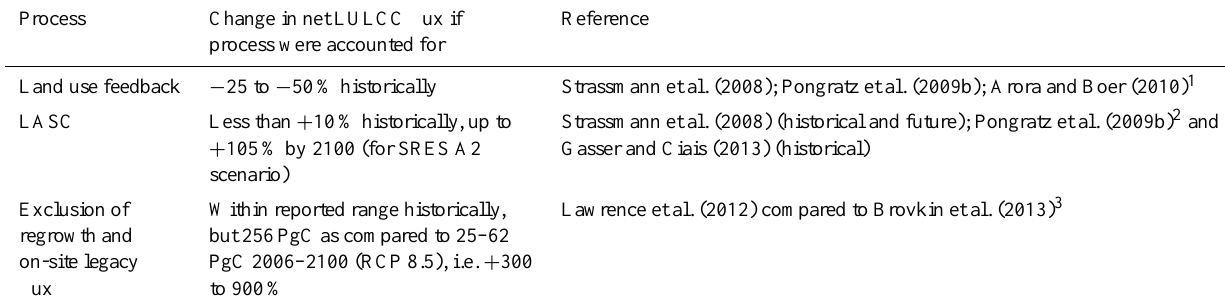
Table 3. Key processes that explain the largest differences between various estimates of the net LULCC flux. LASC is loss of additional sink capacity.